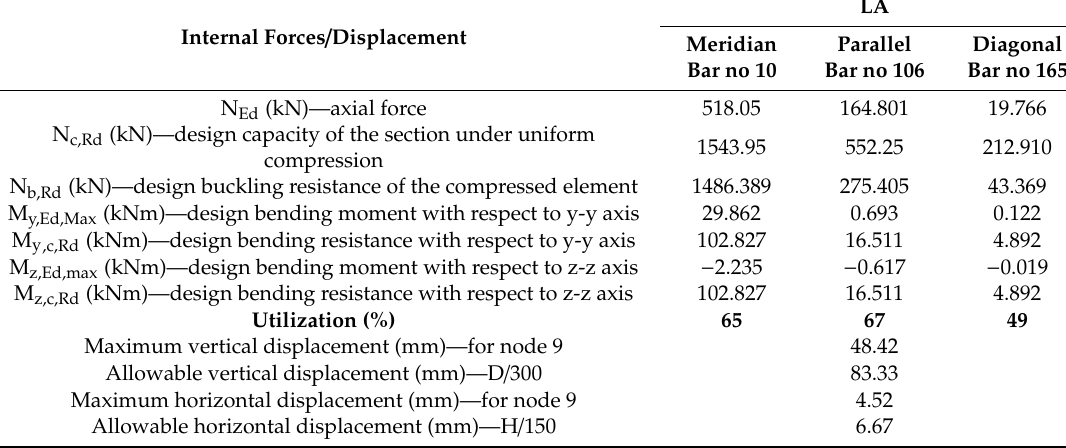
Table 11. Values of the internal forces and the maximum horizontal and vertical displacement of node 9 for